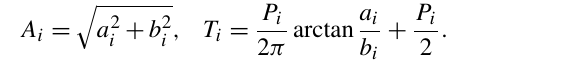
values exceed 70 (50) m s − 1 in the eastward (westward) di- − 8 ( + 6) m s − 1 km − 1 , similar to the values shown by